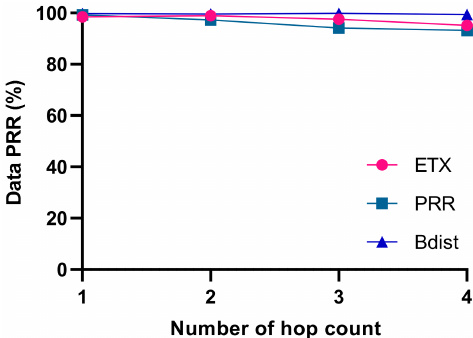
Figure 6. E ff ect of the hop count on network performance.